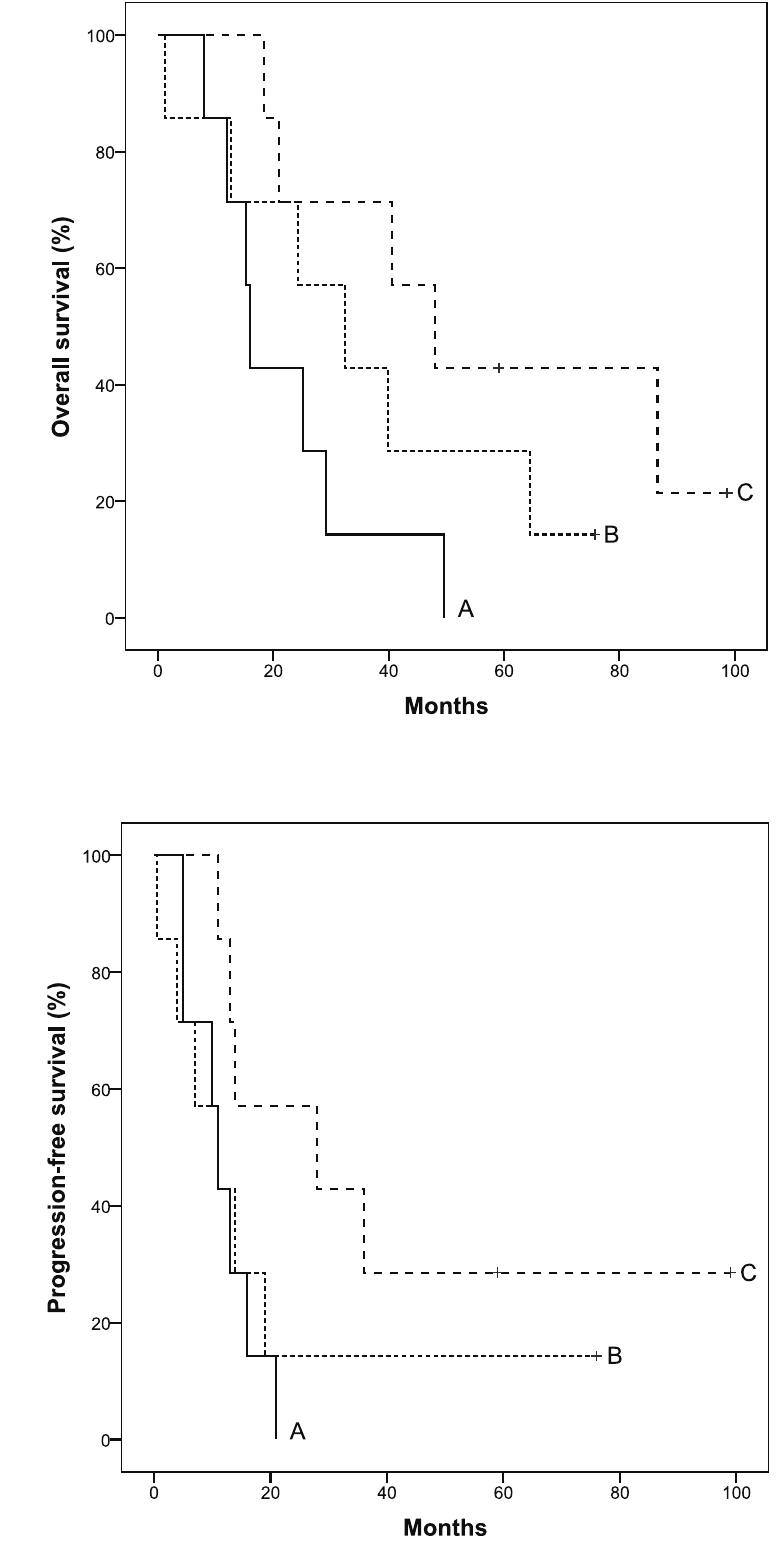
Figure 3. Kaplan-Meier survival curves. Overall survival curves according to ZNF385B mRNA expression level (FC) tertiles ( A ) and progression- free survival curves according to VEGFA mRNA expression level (FC) tertiles ( B ) in patients with moderately and poorly differentiated serous ovarian carcinomas. A: High expression. B: Intermediate expression. C: Low expression.